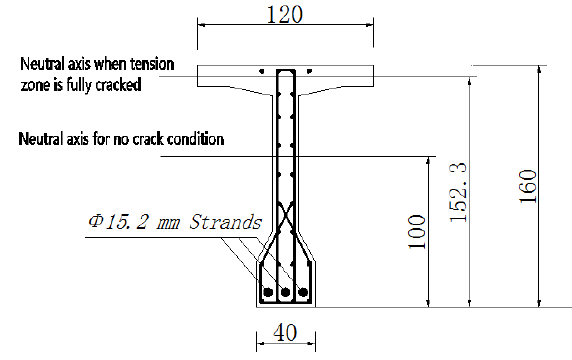
Figure 11. Reinforcements and pre-stressed strands in the cross section at the midspan (unit: cm ). Then, for all available transducers at the upper (R1 ∼ R4) and lower (R5 ∼ R8) portions of the T-beam, lines connecting them are utilized to locate the coordinates of the stress invariant ( ε = 0) through the linear intercepts of the ε diagrams. There are 4 × 4 receiver pairs for each of six source excitations, which implies 96 coordinates of the neutral axis locations can be determined at each loading step.